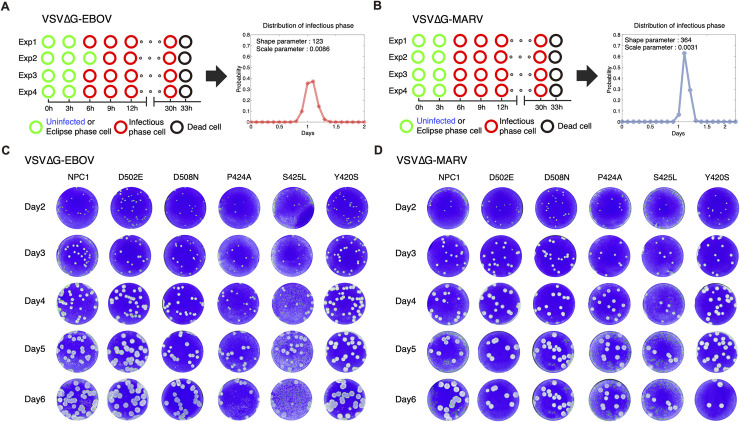
Virus production assays and plaque assays.Virus production assays using Vero E6/NPC1-KO cells expressing human NPC1. Four independent experiments recording cell state every 3 h for VSVΔG-EBOV and VSVΔG-MARV are shown in the left panels of (A) and (B), respectively. Estimated distributions of the infectious phases of each are is also shown in the right panel. Plaque formation of VSVΔG-EBOV (C) and VSVΔG-MARV (D) on Vero E6 cells expressing wildtype NPC1 and five SNP mutants on days 2–6 are shown. Gray spots represent plaques formed by dead cells.